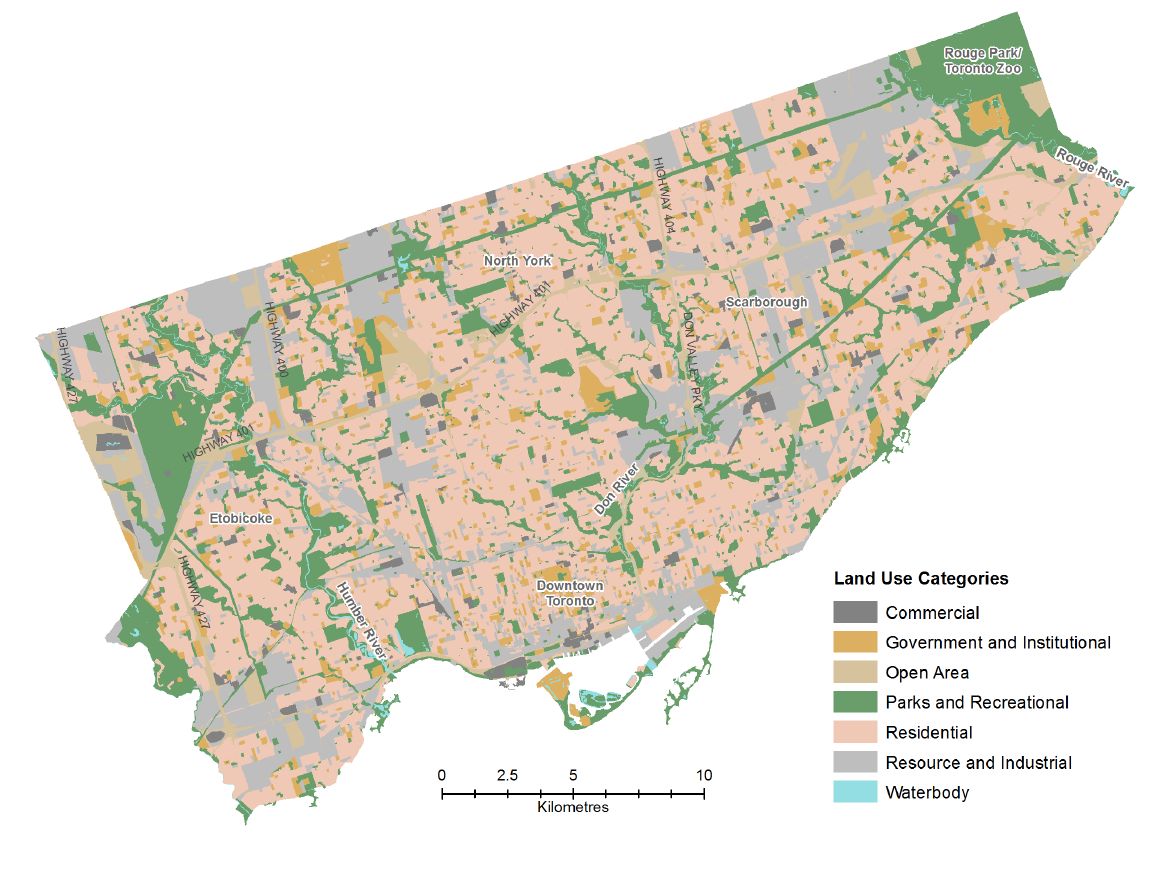
Figure 1. Distribution of land use categories in the City of Toronto (Data source: DMTI